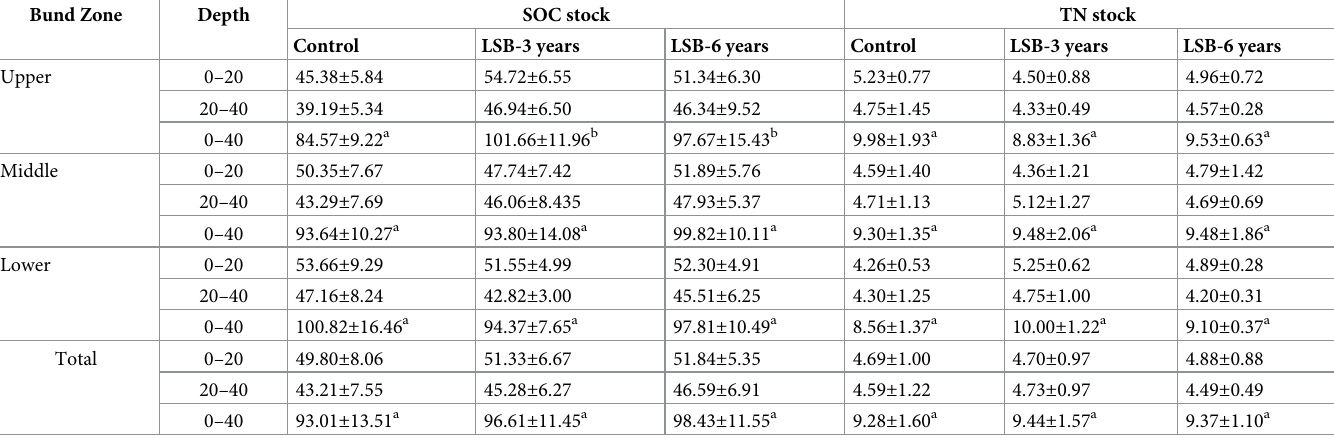
Means followed by the same letter(s) horizontally for the same parameter are not significantly different at (p � 0.05) with respect to treatments and bund zones. (93.01 ± 13.51 Mg ha -1 ) of control (Table 1). Regarding the inter bund zones, the minimum, medium and maximum SOC stock for the control were recorded in the upper, middle and lower inter bund zones, respectively. While for farmland treated with LSB-3 years, the maxi-